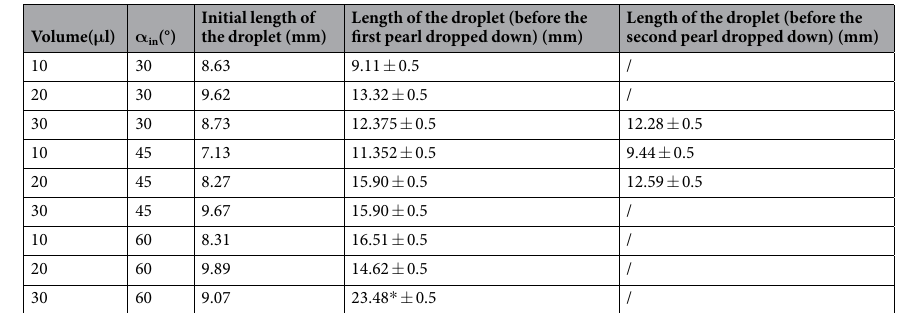
Table 1. The maximum length L of the droplets before breakup for droplets with volume of 10 μ l, 20 μ l, and 30 μ l at inclinations of the plate of 30°, 45°, and 60°. The symbol ‘ * ’ denotes the exceptional case that there are three pearl drops left from the previous droplet which are dropped simultaneously at or around the position of droplet’s advancing end of initial state.